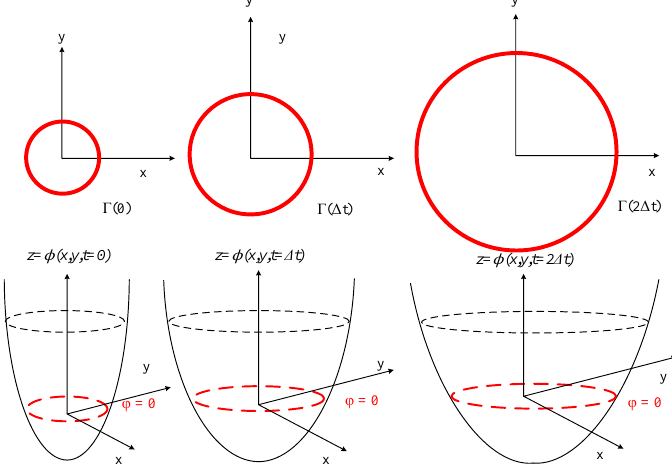
with the moving level set function 𝛤𝛤 ( 𝑡𝑡 )